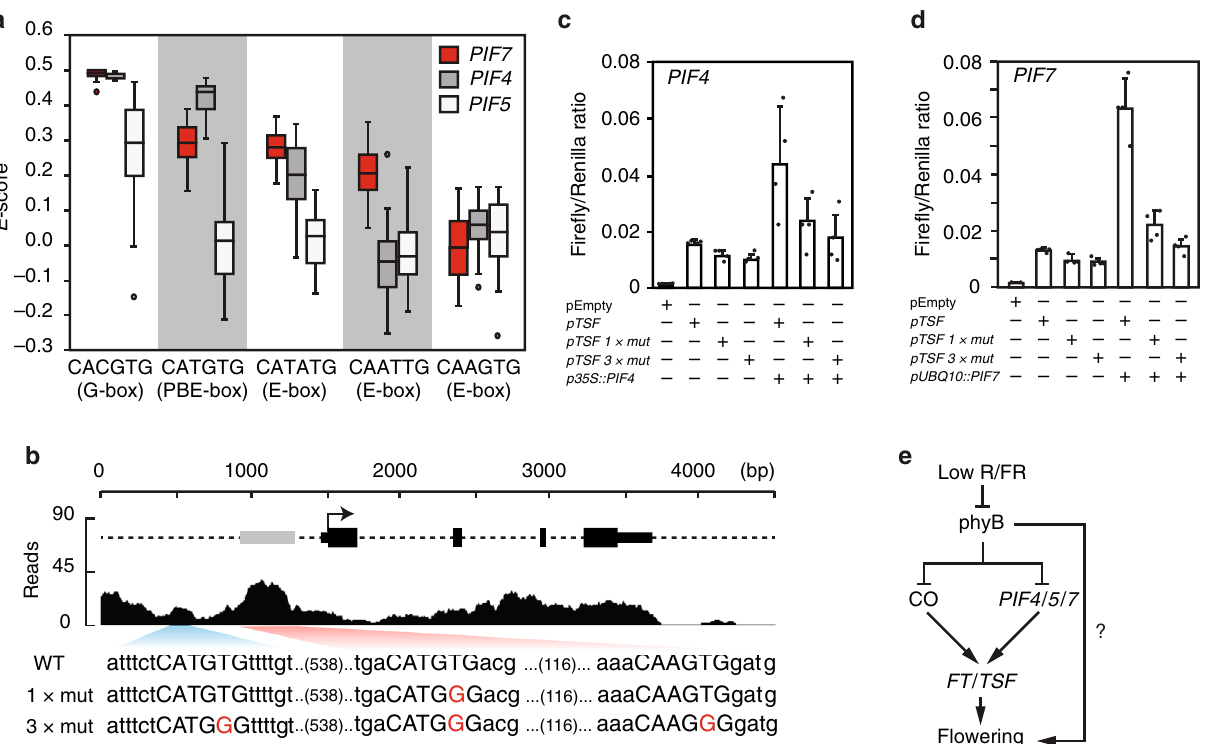
Fig. 4 PHYTOCHROME-INTERACTING FACTORS (PIF) proteins directly regulate TWIN SISTER of FT ( TSF ) expression. a PIF7 preferentially bind to G- boxes (CACGTG) and PBE-boxes (CATGTG) in protein-binding microarray using PIF7_bHLH-MBP (Supplementary Table 2). Data corresponding to PIF4 and PIF5 were previously described 8 and shown here for comparison. Box plot represents the distribution of enrichment scores ( E -scores) for G- and PBE- boxes, as well as for other E-boxes indicated. E -score is a rank-based, non-parametric measure of binding af fi nity that ranges between − 0.5 and + 0.5 and is calculated from the median intensity of all the oligonucleotide probes that contain a given 8-mer motif 78 . Boxes represent quartiles 25 – 75%, the black line within represents the median of the distribution (quartile 50%) and dots denote outliers of the distribution. b Representation of PIF4 chromatin immunoprecipitation-sequencing (ChIP-seq) reads mapped to the TSF locus 10 . Gray box represents high-con fi dence PIF4 binding peak at TSF promoter and nucleotide sequence represents the wild-type (WT) and mutant version containing 1 (1× mut) or 3 mutations (3× mut) used for transient dual-luciferase assays in Nicotiana benthamiana . c , d Luciferase ratio corresponds to the average of pTSF:: fi re fl yLUC and p35S::renillaLUC ratio of four independent in fi ltrations and error bars correspond to standard deviation; individual data points are indicated with black dots. e Model of low R/FR-regulated